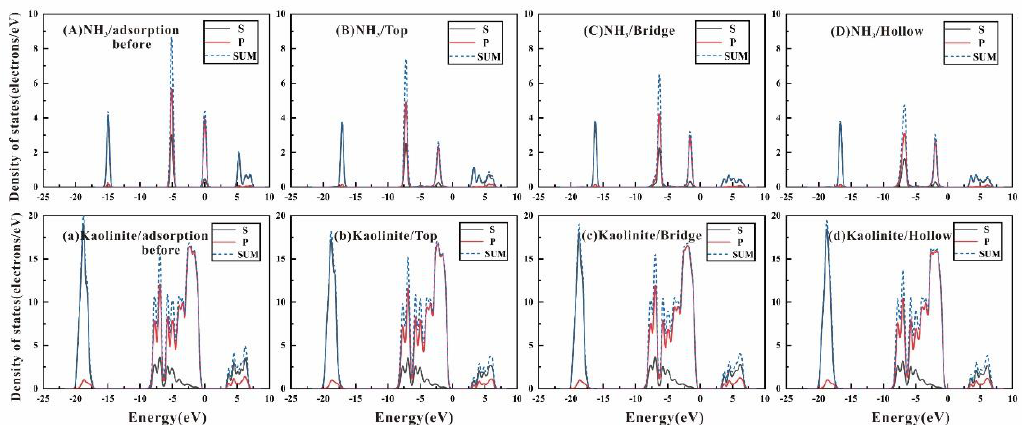
Figure 7. The PDOS plots for the NH 3 molecule and the Kaolinite surface atoms at the “Top”, “Bridge” and “Hollow” adsorption sites: ( A ) for NH 3 before adsorption; ( a ) for Kaolinite before adsorption; ( B – D ) for NH 3 adsorption on “Top”, “Bridge” and “Hollow” sites; ( b – d ) for kaolinite (001) surface after NH 3 adsorbed on “Top”, “Bridge” and “Hollow” positions.